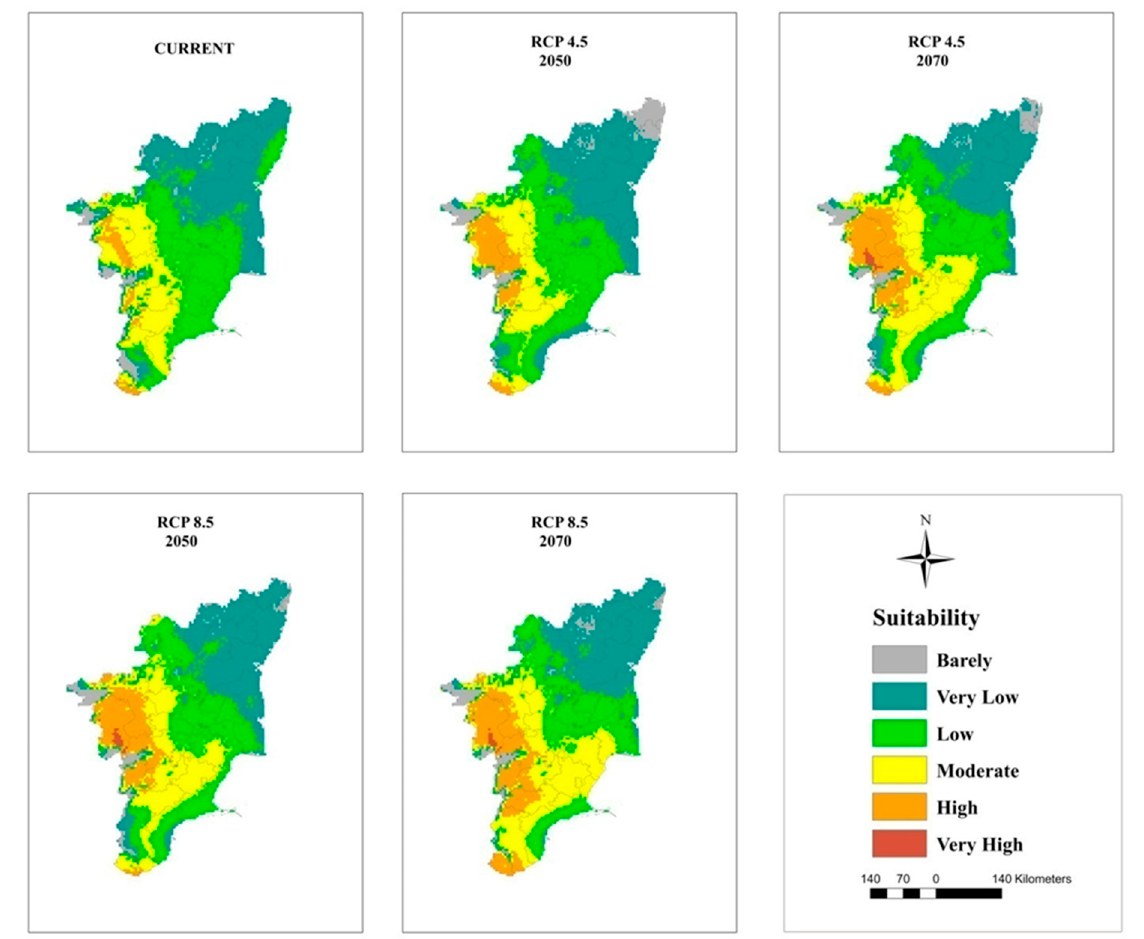
Figure 8. Climatically suitable areas for coconut production in Tamil Nadu under the current and future climates of the 2050s and 2070s for RCP 4.5 and RCP 8.5 as modeled by MaxEnt.